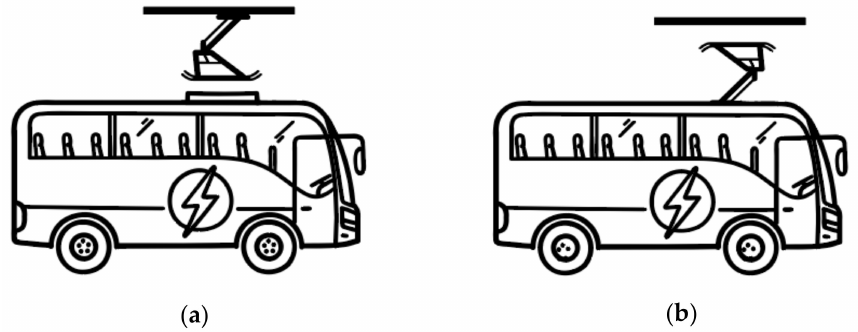
Figure 16. Representation of ( a ) Top-Down and ( b ) Bottom-Up